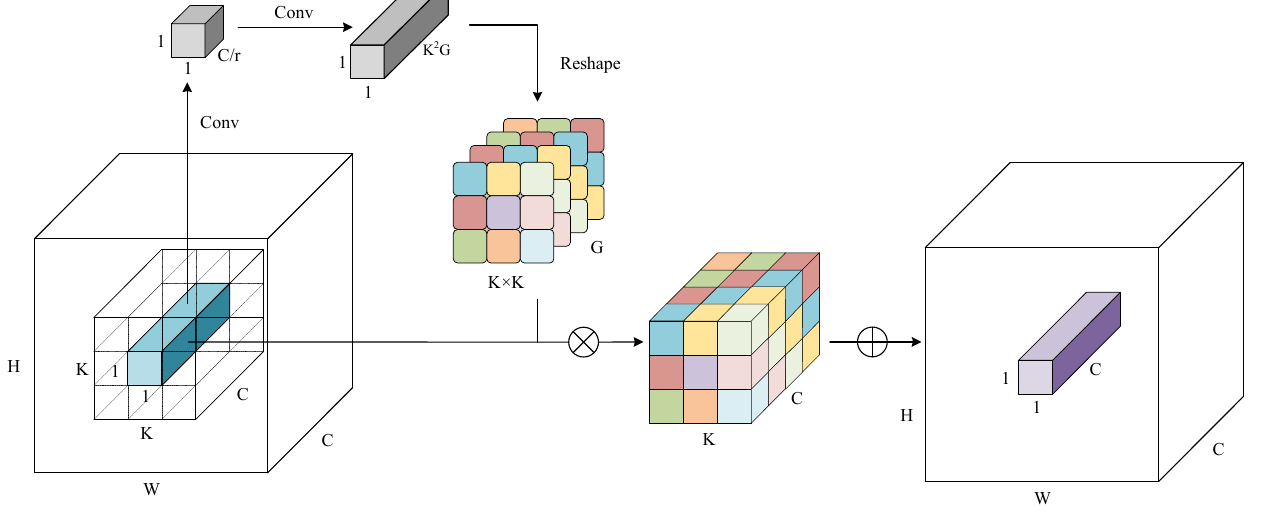
Figure 1. The blue block is the feature vector to be processed and the compressed purple block is the feature vector after involution. h and w are the height and width of the feature, respectively, C is the number of channels, r is the compression rate, K × K is the kernel size and G is the number of groups. The feature vectors to be processed are first compressed by convolution, then expanded by convolution, and then reshaped into G kernels of size K × K. The generated kernels are dot product and summed with the feature vectors to be processed and the feature vectors in their surrounding K × K range to obtain the processed feature vectors. The number of feature channels processed by involution is constant. In order to adapt to the change of channels in the U-Net network and to apply it better in the upsampling and downsampling process, we add a convolution operation after each involution operation, as shown in Figure 2, and the involution block consists of Relu-involution-conv-BN together. In addition, in the outermost layer of the network we do not use the involution block but the convolution block containing Relu-conv-BN. The grey block and the blue block together form the U-Net network, the purple block added in the middle layer is the self- attentive block and the orange block is the residual block. The blue lines indicate jump links, which place the low-dimensional features encoded by the encoder into the decoder to be merged with its feature vector and decoded together in the next step. The addition of jump links allows valid features to pass directly through the network layer, preserving low-dimensional features and avoiding spatial redundancy of